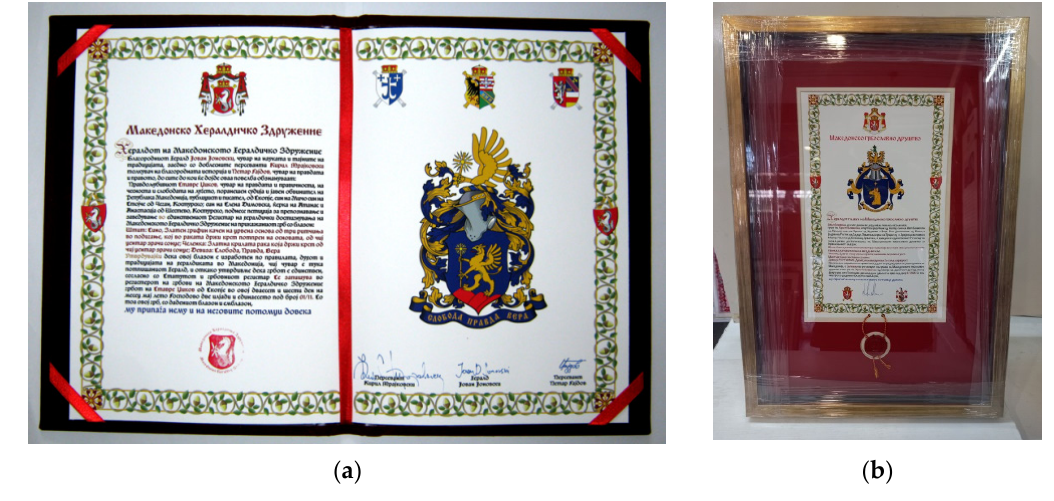
Figure 23. Matricula ( a ) Hardcover version; ( b ) Framed